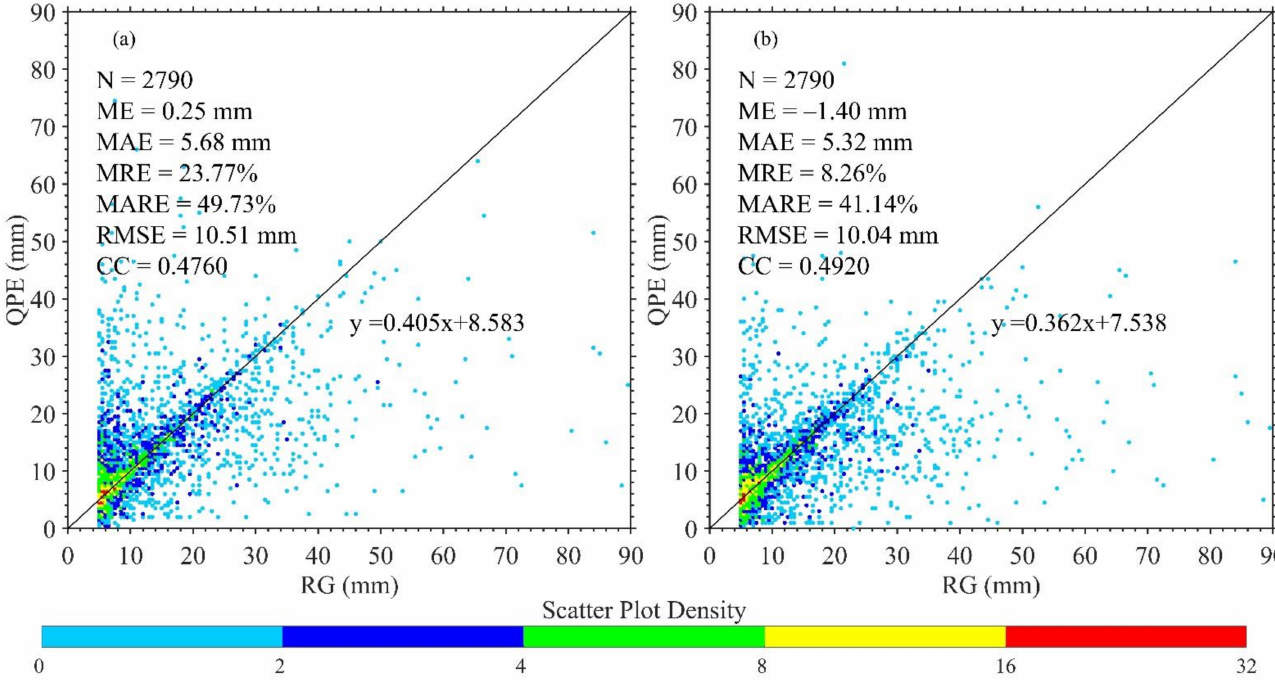
Figure 7. The scatter density plots of the RG hourly precipitation vs ( a ) the secondary FY-4A QPE and ( b ) the improved FY-4A QPE from June to August of 2020 in Western